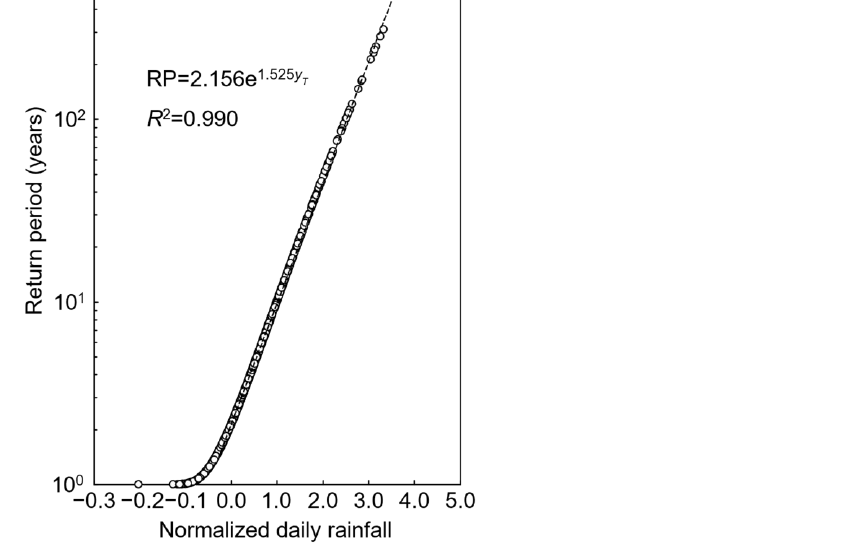
Figure 7. Relationship between normalized values of annual maximum daily rainfall and the